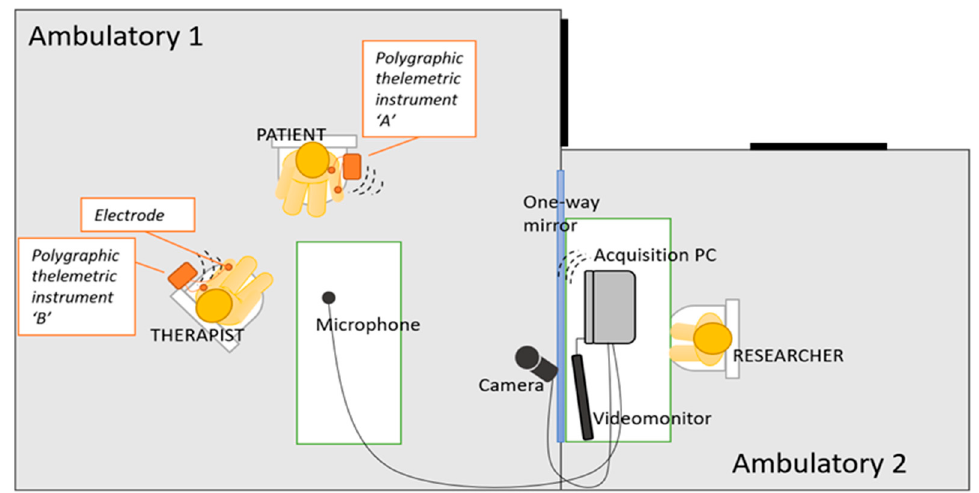
Figure 2. Organization of space during psychophysiological recording sessions.